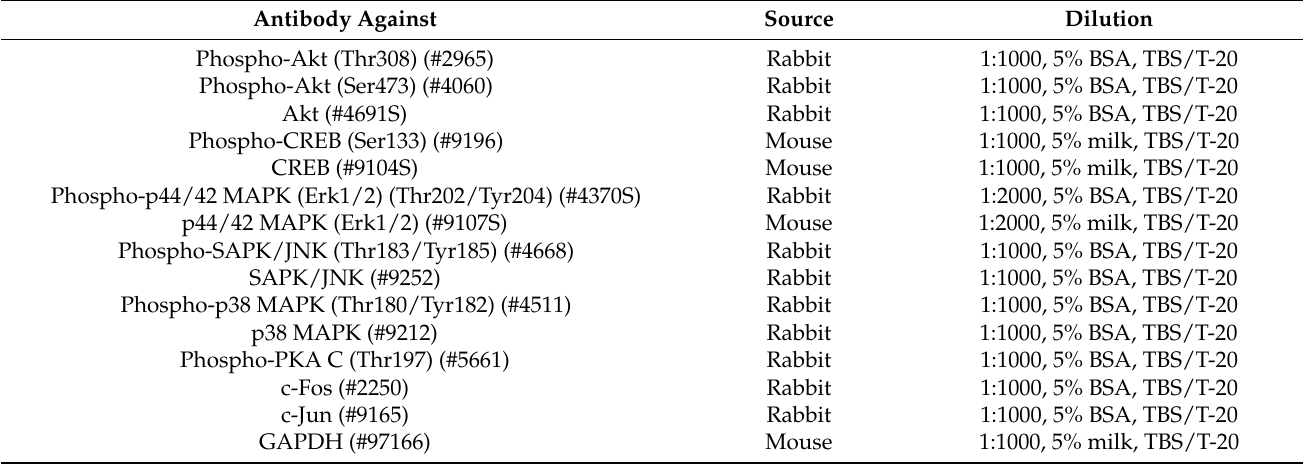
Table 5. Primary antibodies used for immunoblotting and their